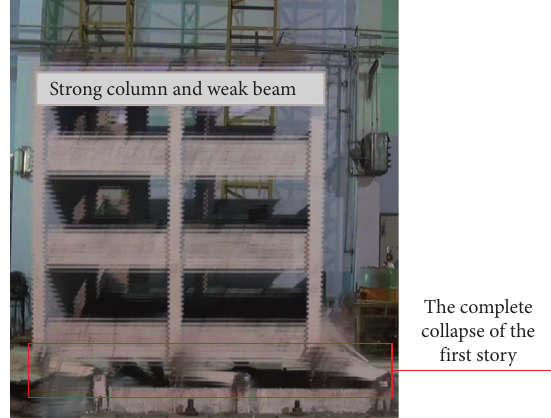
Figure 30: First-floor collapse of the test (front).